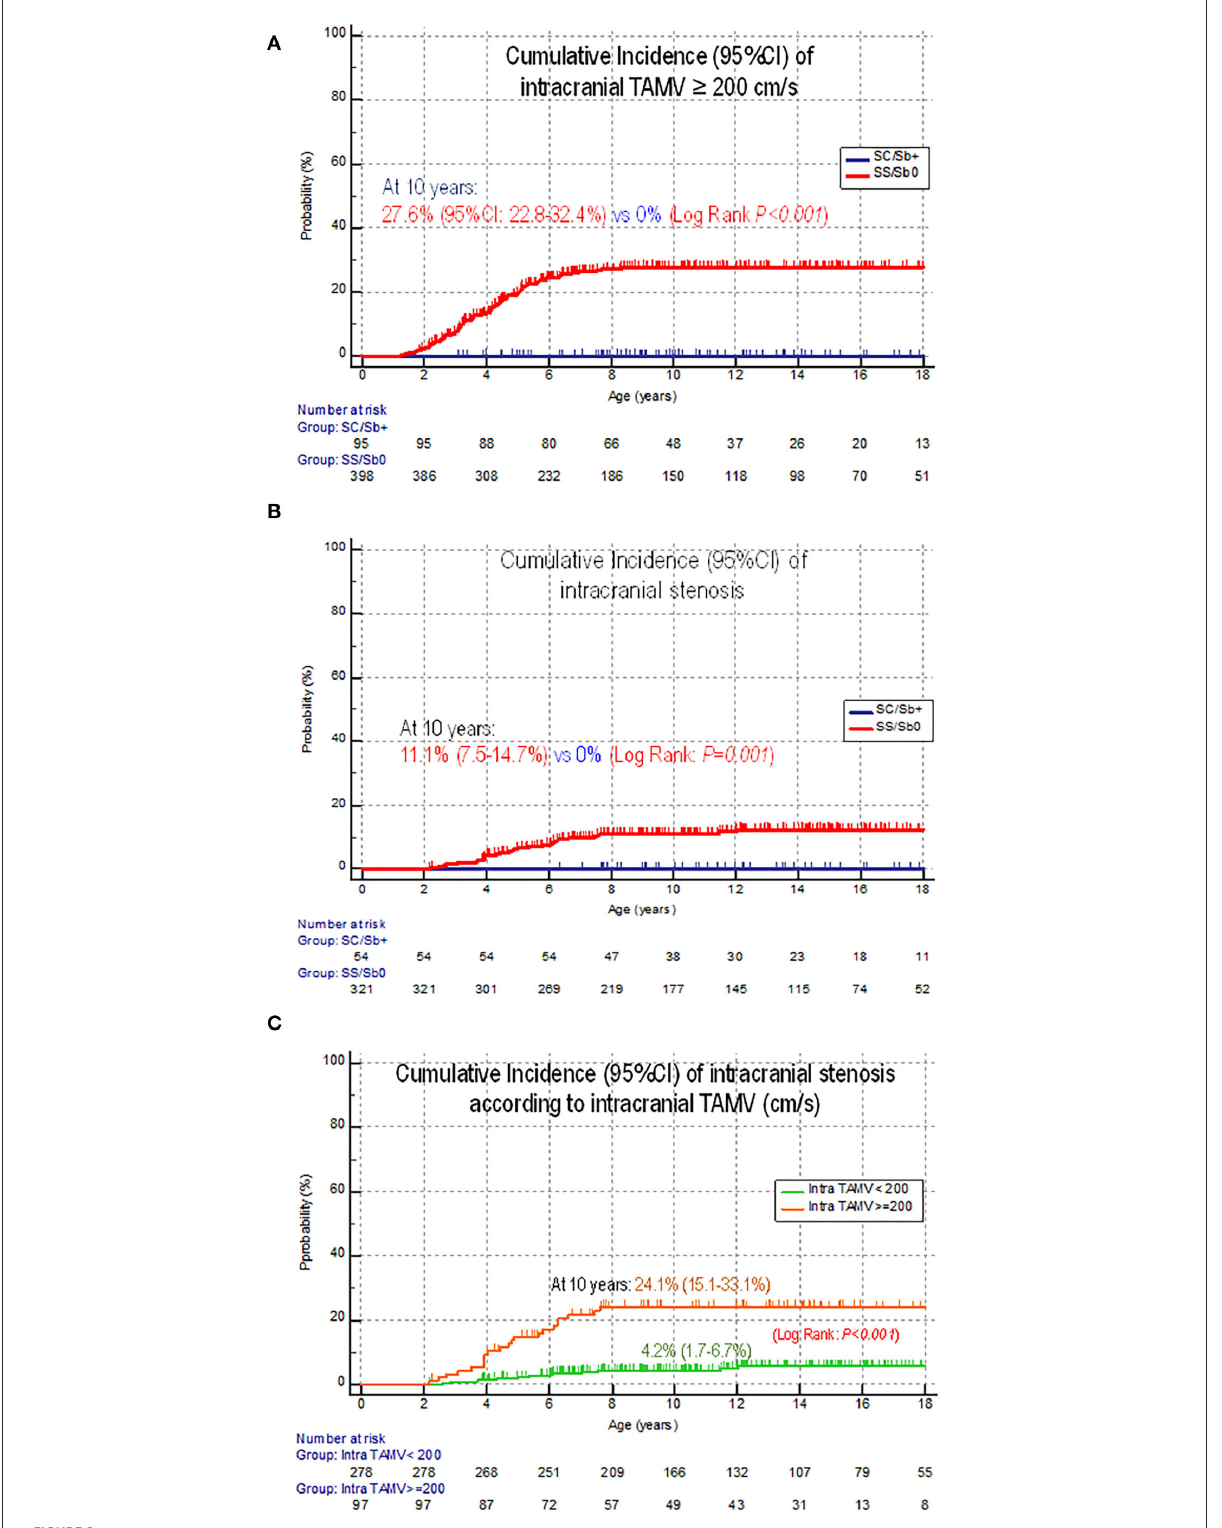
FIGURE2 Comparative cumulative incidence of intra- and extracranial arteriopathies in SCA vs SC/Sb + children and according to TAMV. (A) Intracranial TAMV ≥ 200 cm/s. (B) Intracranial stenosis. (C) Intracranial stenosis according to a history of TAMV ( < or ≥ 200 cm/s). Of note, among the 13 patients with stenosis but no history of TAMVs ≥ 200 cm/s, 10 had a history of conditional TAMV (170–199 cm/s), one had no temporal window with underlying severe intracranial arteriopathy, one had a stroke related to extracranial arteriopathy, and no obvious reason was found in one